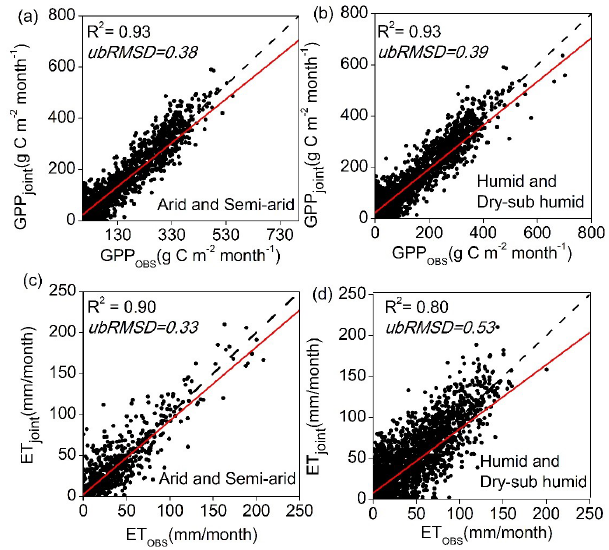
Figure 8. Scatter plots of daily tower GPP and ET versus GPP joint and ET joint under arid and humid sites: (a, c) the fitting results of GPP and ET in arid and semi-arid regions, respectively, and (b, d) the fitting results of GPP and ET in humid and dry sub-humid zone, respectively.